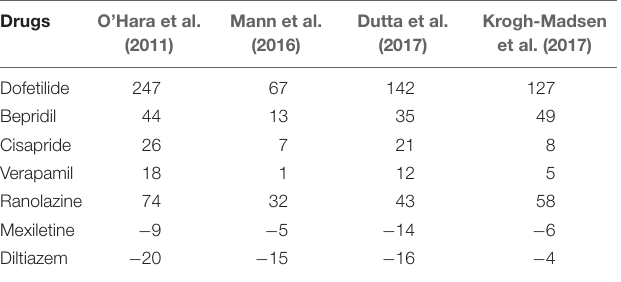
TABLE 5 | Simulated (cid:49) JT peak c for various drugs with different cell models (Unit: ms).